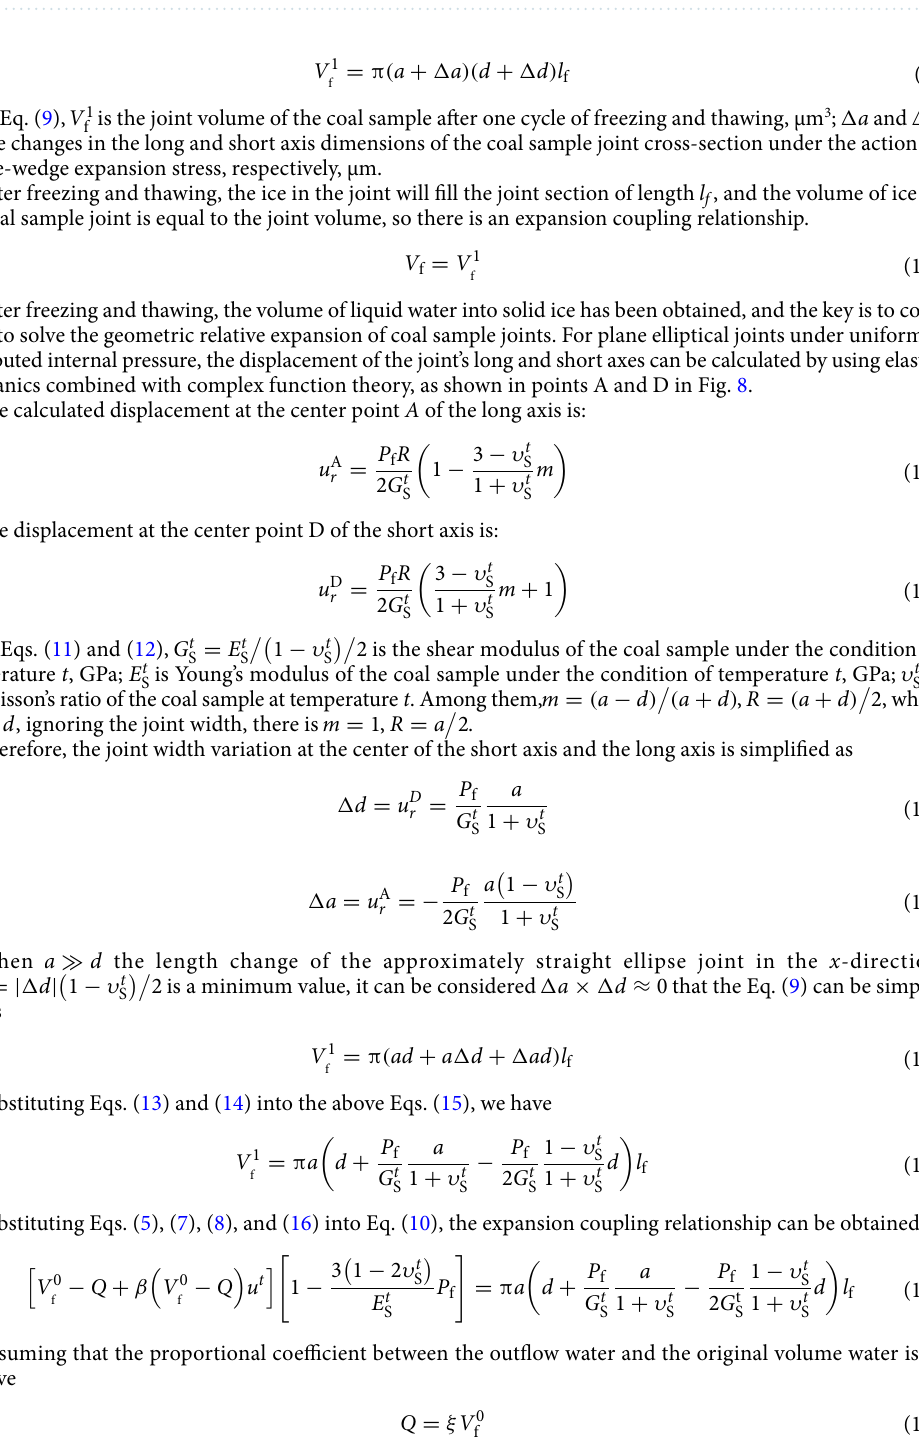
Figure 8. Schematic diagram of the oval joint